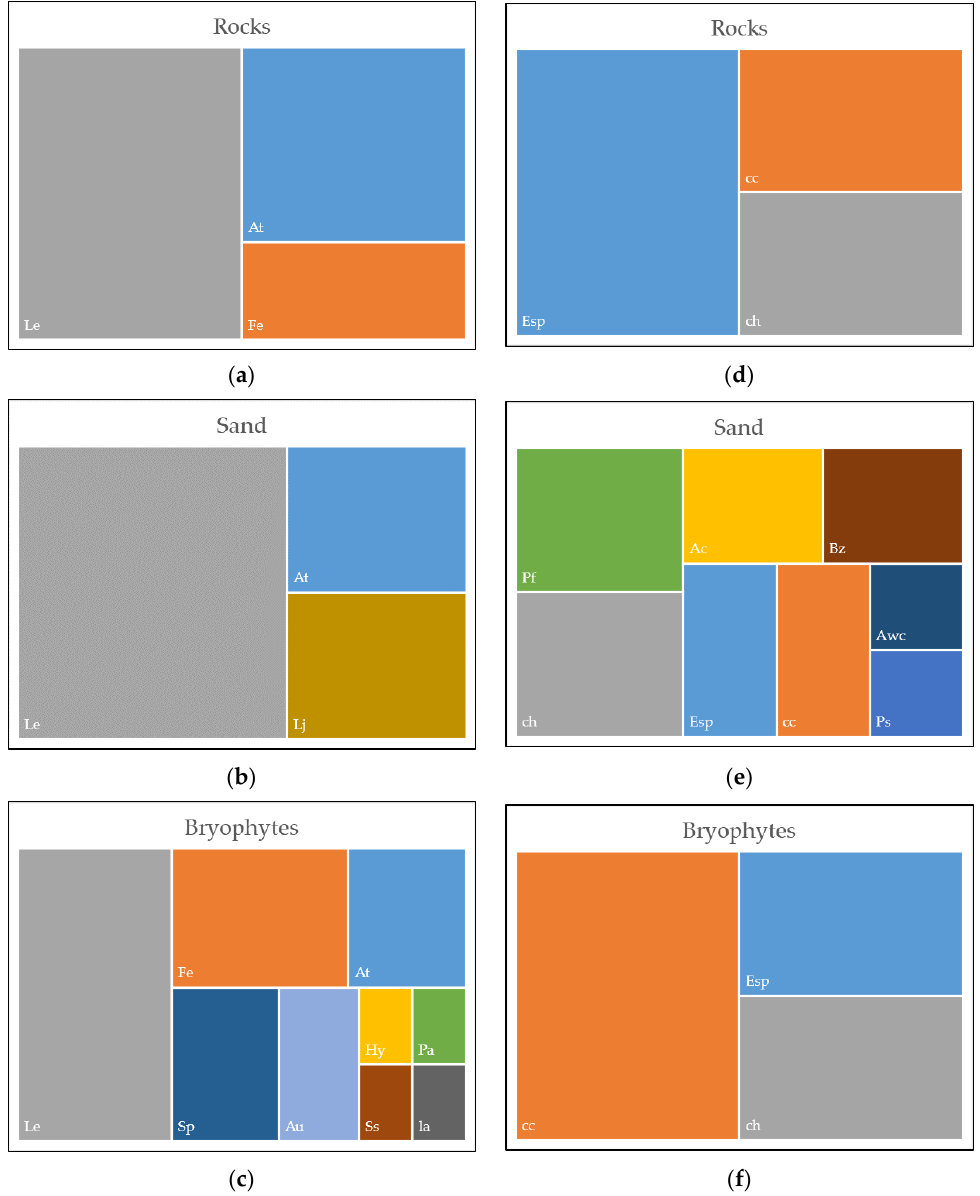
Figure 6. ( a – c ) Treemaps of habitat preferences for Hydrachnidia (left column) and ( d – f ) Copepoda (right column) according to the standardized selection index (B > 0.33 representing habitat selection; larger rectangles depict taxa with higher percentages of springs where rocks, sand, or bryophytes were preferred; taxa abbreviations are as in Table 2).